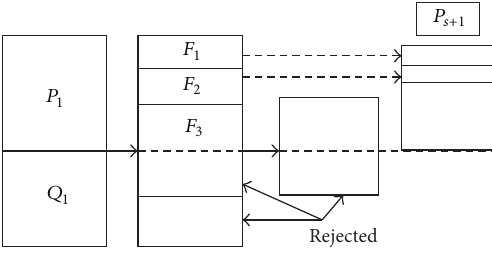
Figure 6: Sorting population using NSGA-II algorithm.